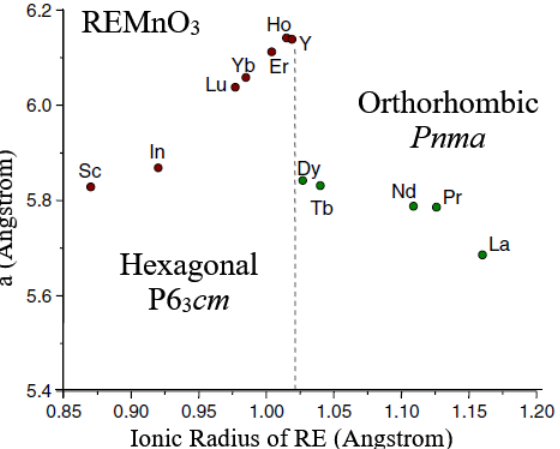
Figure 8. Evolution of the lattice structure in REMnO 3 as a function of the size of the rare-earth (RE) element. Reprinted from Ref. [57].